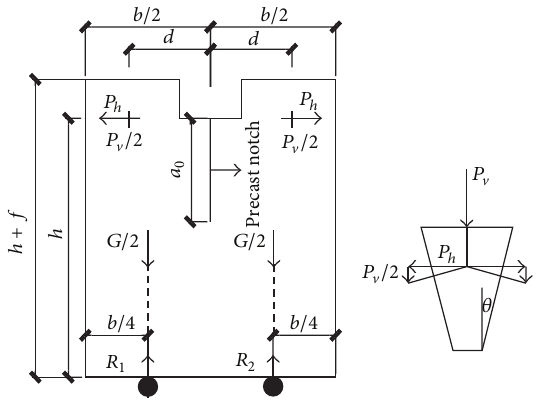
Figure 7: Geometry of